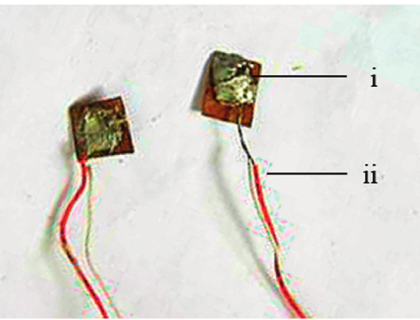
Figure 7: T-type thermocouple. (i) Copper; (ii) constantan wire.